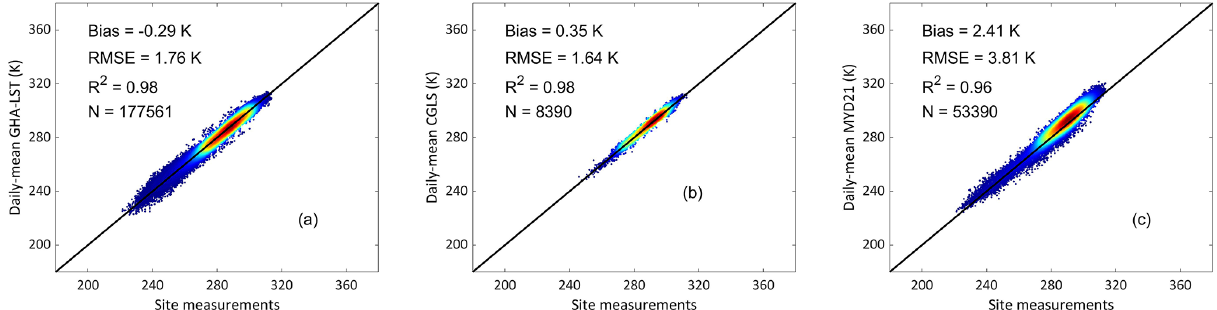
Figure 5. Density scatterplots of the daily mean LST samples from (a) GHA-LST, (b) CGLS, and (c) average daytime and nighttime MYD21C1